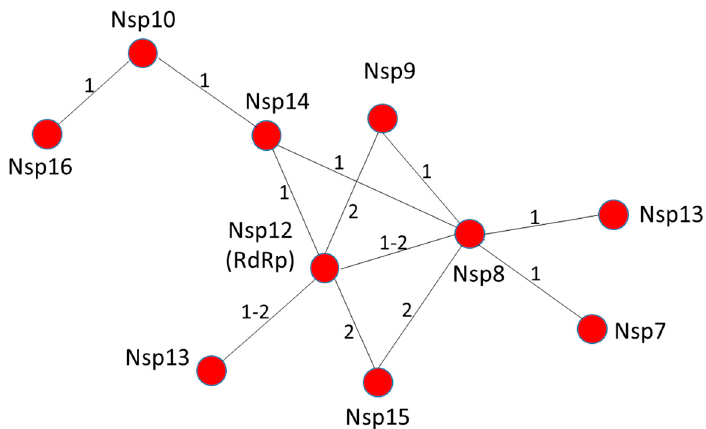
Figure 2. Nsp12 and Nsp8 are a hub for interactions among actors of the RNA replication machinery. Predicted pattern of interactions based on the available literature data. The numbers 1 and 2 on the strings refer to SARS-CoV and MHV, respectively.